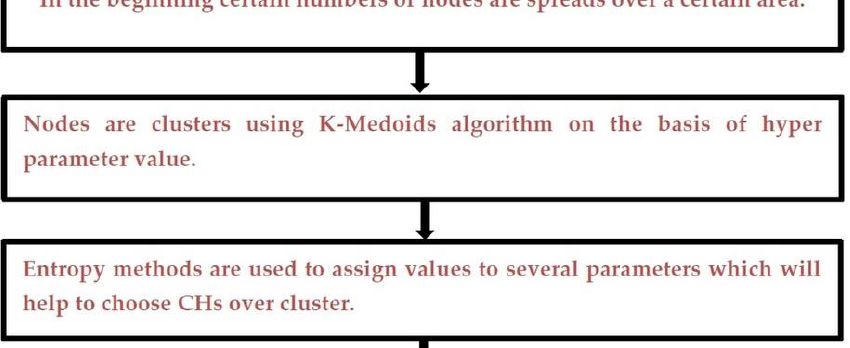
Figure 1. General structure of WSNs.